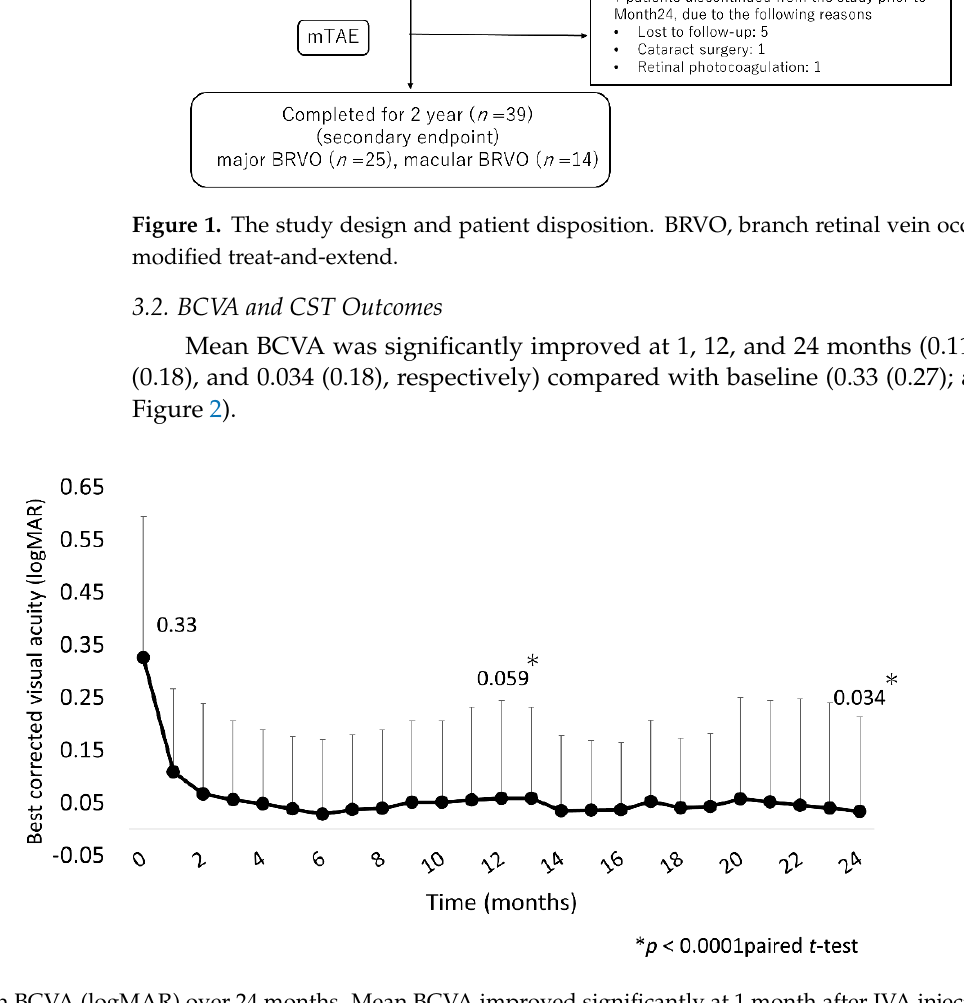
Figure 2. Mean BCVA (logMAR) over 24 months. Mean BCVA improved significantly at 1 month after IVA injection, with the improvement continuing through to 24 months. BCVA, best-corrected visual acuity; IVA, intravitreal aflibercept.